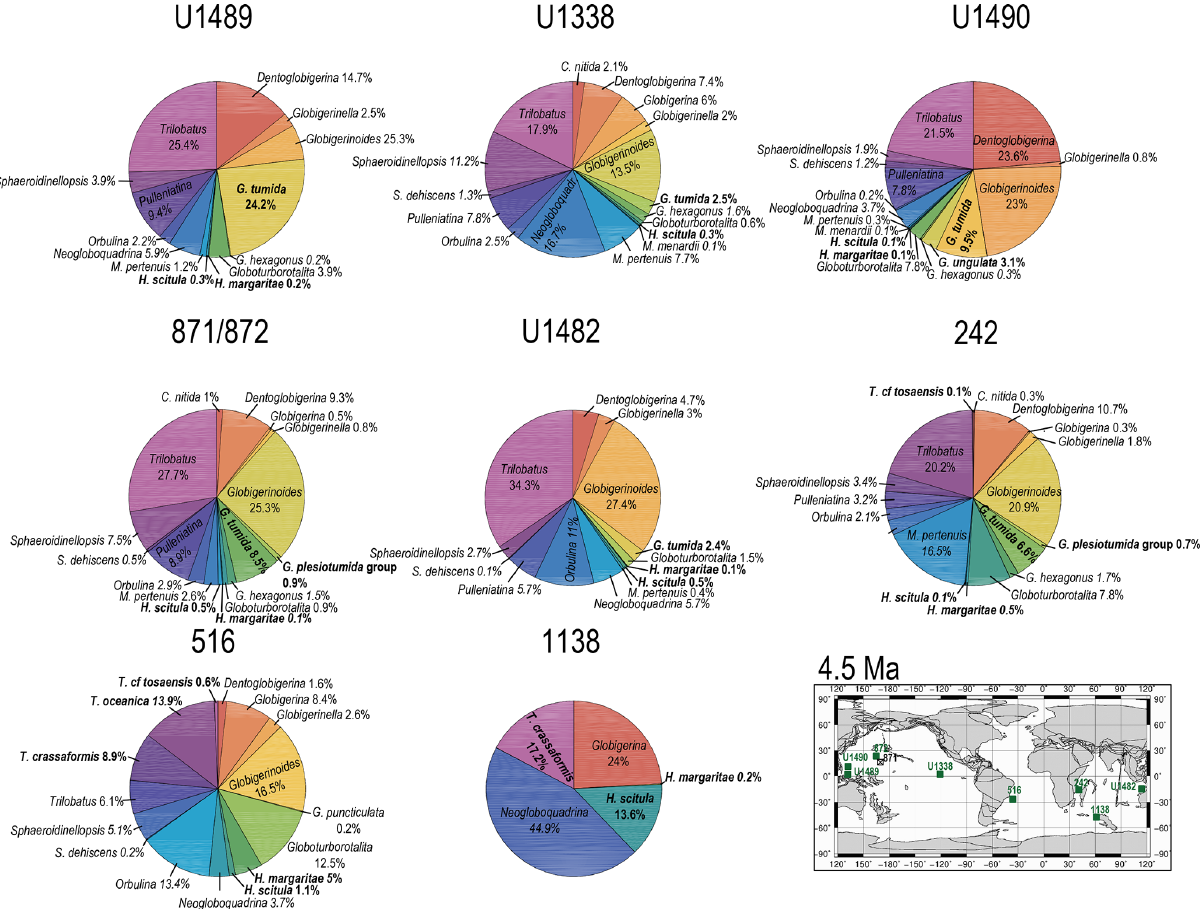
Figure 9. Abundance and biogeography of planktonic foraminiferal species at 4.5Ma. In the pie charts, twilight zone planktonic foraminiferal species are in bold. Sites where twilight zone planktonic foraminifera were found are highlighted in green in the maps. The crossed square symbol in the maps indicate that the time interval of interest was not recovered for a given site. Continental configuration follows the Ocean Drilling Stratigraphic Network (GEOMAR; Kiel,